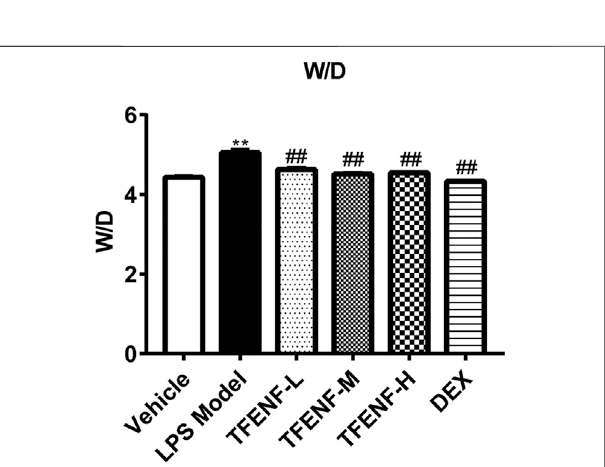
FIGURE 4 | Effects of TFENF on the W/D ratio in LPS-induced ALI. EffectsofTEFNFontheW/Dratioinratlungs6 hafterLPSchallenge( n (cid:2) 6per group). Data are presented as mean ± S.E.M. **p < 0.01 compared with the vehicle group; ## p < 0.01 compared with the LPS model